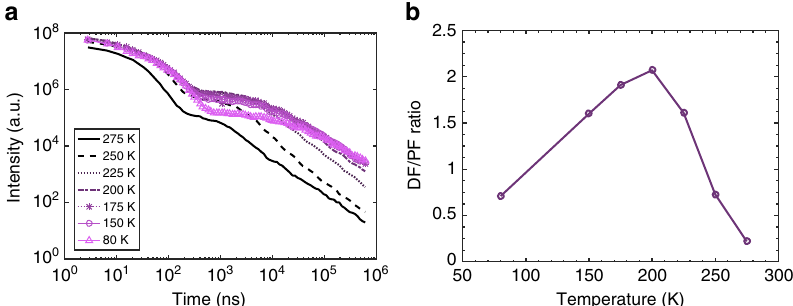
Figure 6 | Photoluminescence decay profiles and temperature-dependent DF/PF ratio of DPTZ-DBTO2 in polyethylene oxide. ( a ) The time-normalized decay profiles of DPTZ-DPTO2 in PEO over a temperature range from 275 to 80K. The maximum rISC rate is observed around the resonance at 225–200K, which is highlighted from the higher magnitude over which the delayed fluorescence is onset. ( b ) The ratio between the delayed fluorescence and prompt fluorescence of DPTZ-DBTO2 in PEO over a range of temperatures. The prompt fluorescence regime was taken to be between zero time and 250ns, with the delayed fluorescence regime chosen as being between that and 7.7 m s. The later times have been discounted due to the possible influence of phosphorescence thus these ratios are only relative and not